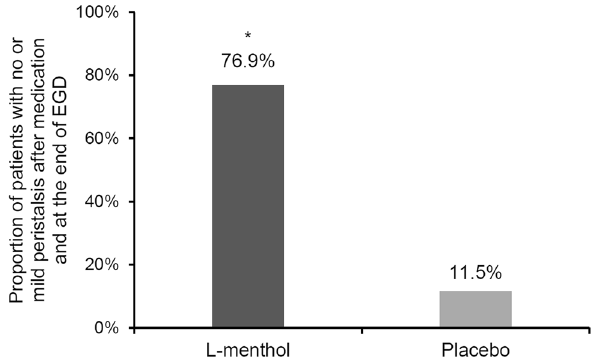
Figure 4. The proportion of patients with no (grade 1) or mild (grade 2) peristalsis after medication and at the end of EGD with l-menthol or placebo sprayed on the gastric mucosa. * p < 0.001. EGD esophagogastroduodenoscopy.